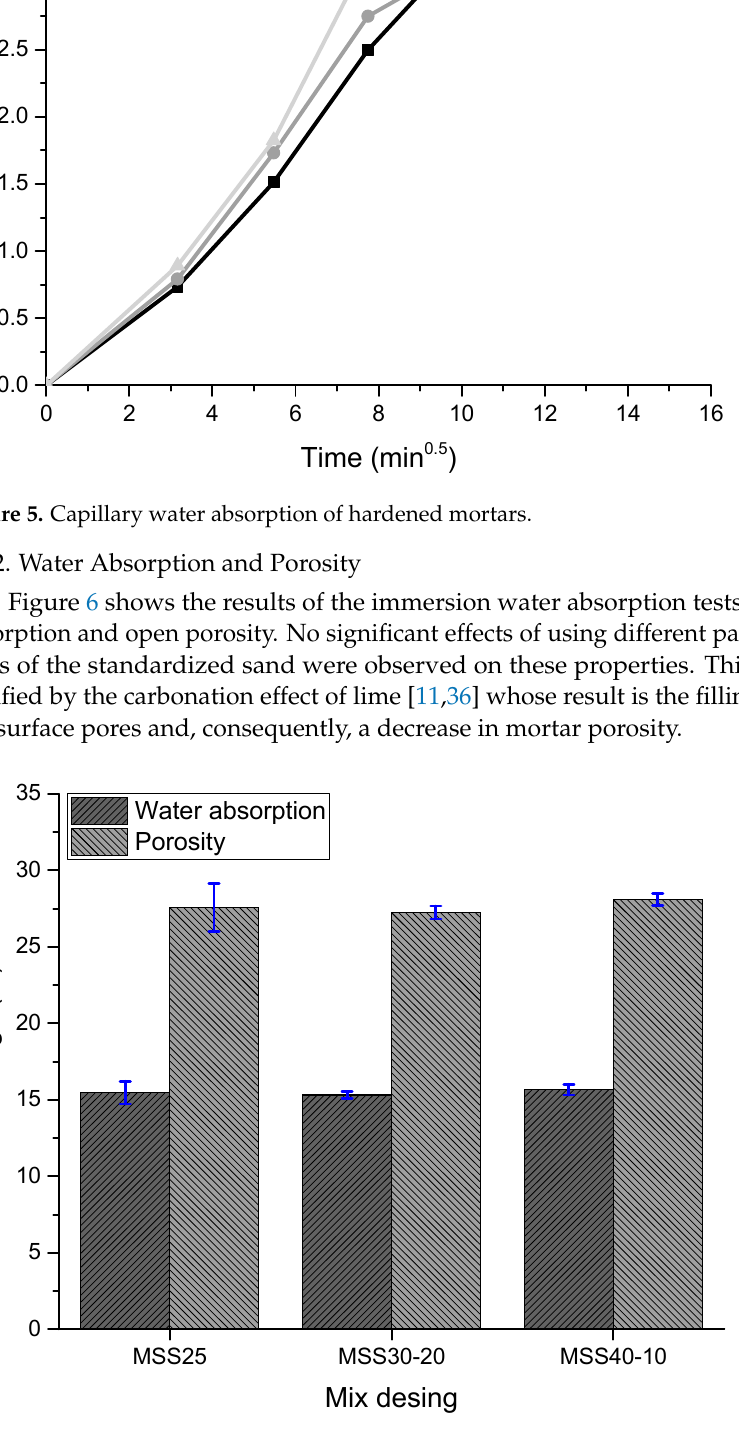
Figure 6. Water absorption and porosity of hardened mortars.